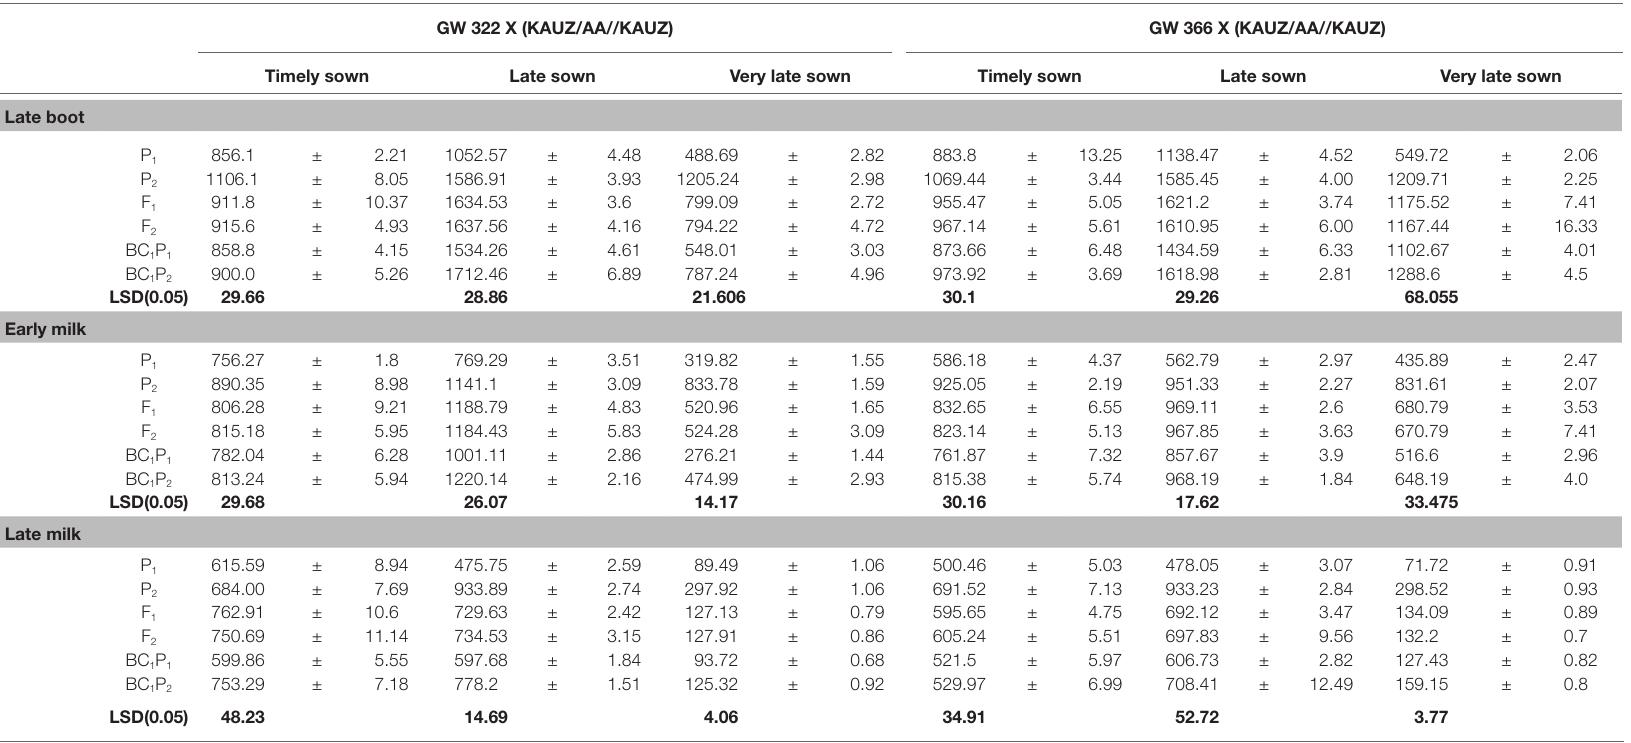
TABLE 2 | Mean stomatal conductance mmolm −2 s −1 with their standard error measured on parental, F 1, and segregating generations for two crosses GW 322 X (KAUZ/AA//KAUZ) and GW 366 X (KAUZ/AA//KAUZ) under timely, late, and very late sown condition. GW 322 X (KAUZ/AA//KAUZ) GW 366 X (KAUZ/AA//KAUZ) Timely sown Late sown Very late sown Timely sown Late sown Very late